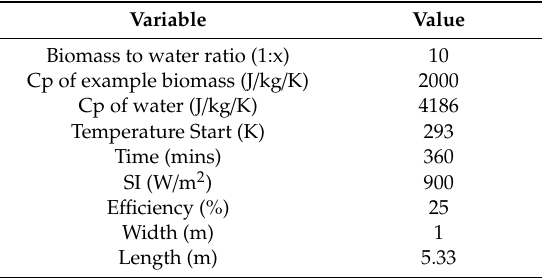
Table 5. Constant variables for the energy demand in the second example